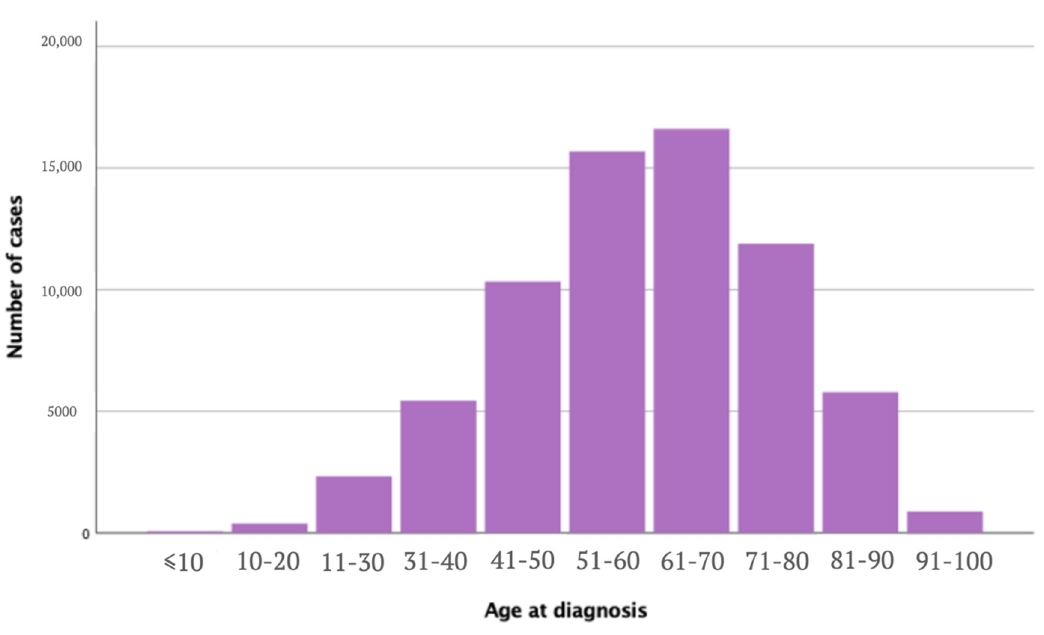
Figure 2. Number of melanomas of the upper limbs and shoulders cases by age